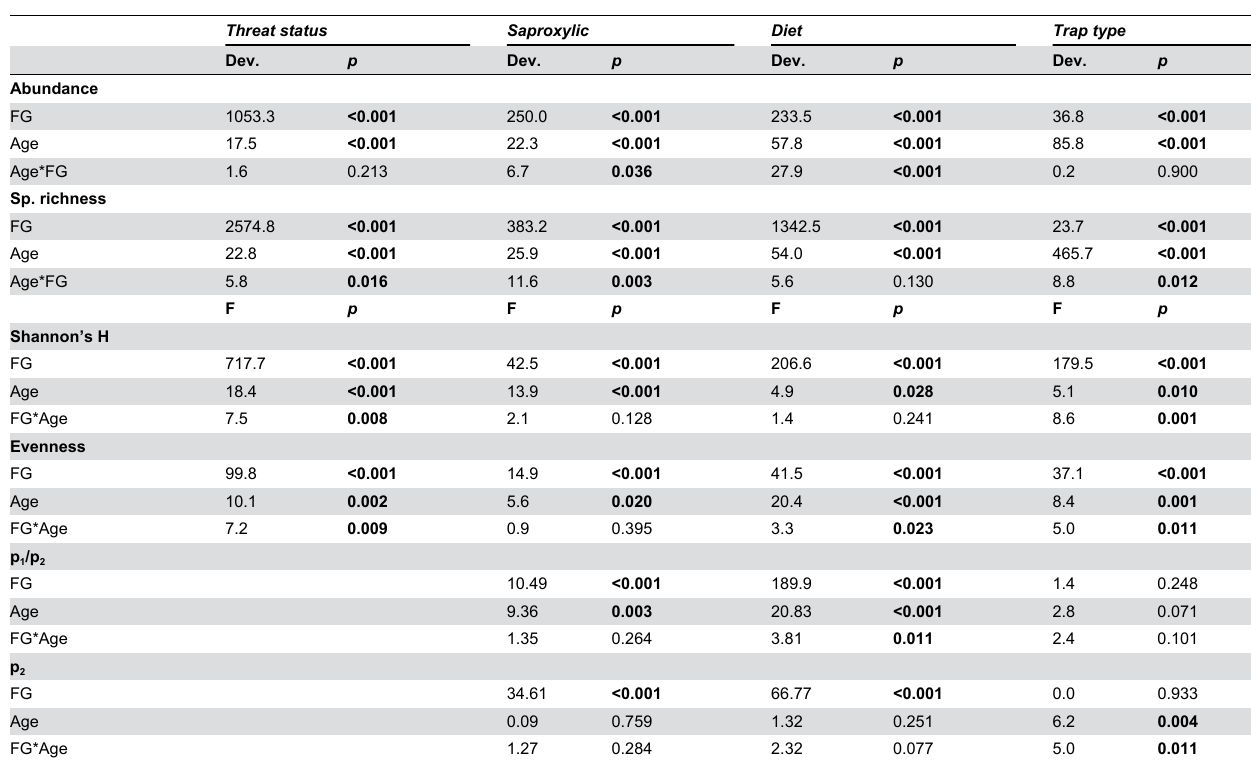
Table 3. Analysis of the effect of functional group (FG), stand age and their interaction on measures of